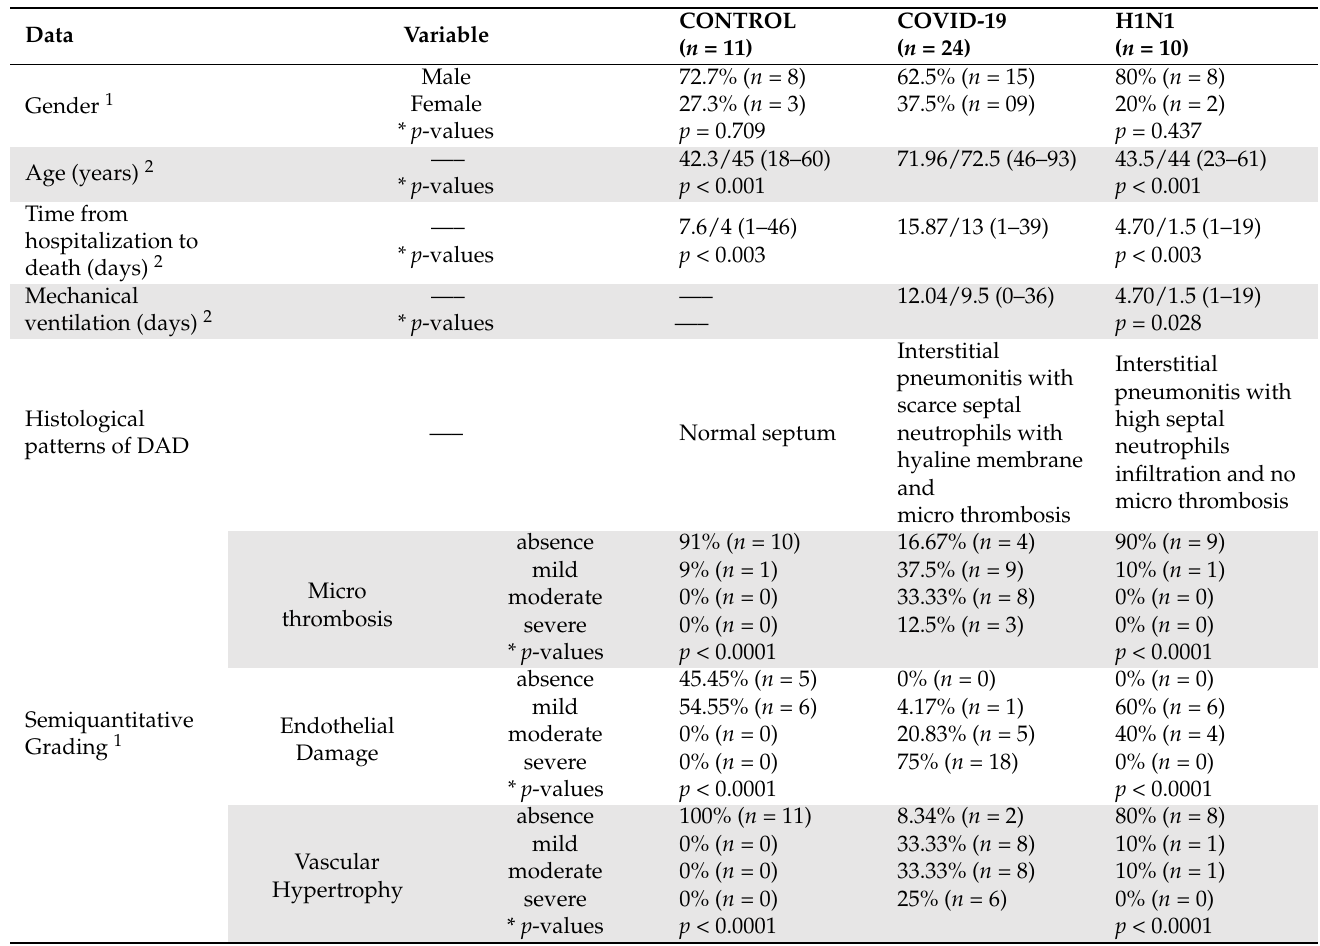
Table 1. Comparative Table between COVID-19, H1N1 and CONTROL groups for gender, age, time from hospitalization to death, mechanical ventilation time, and histological patterns of